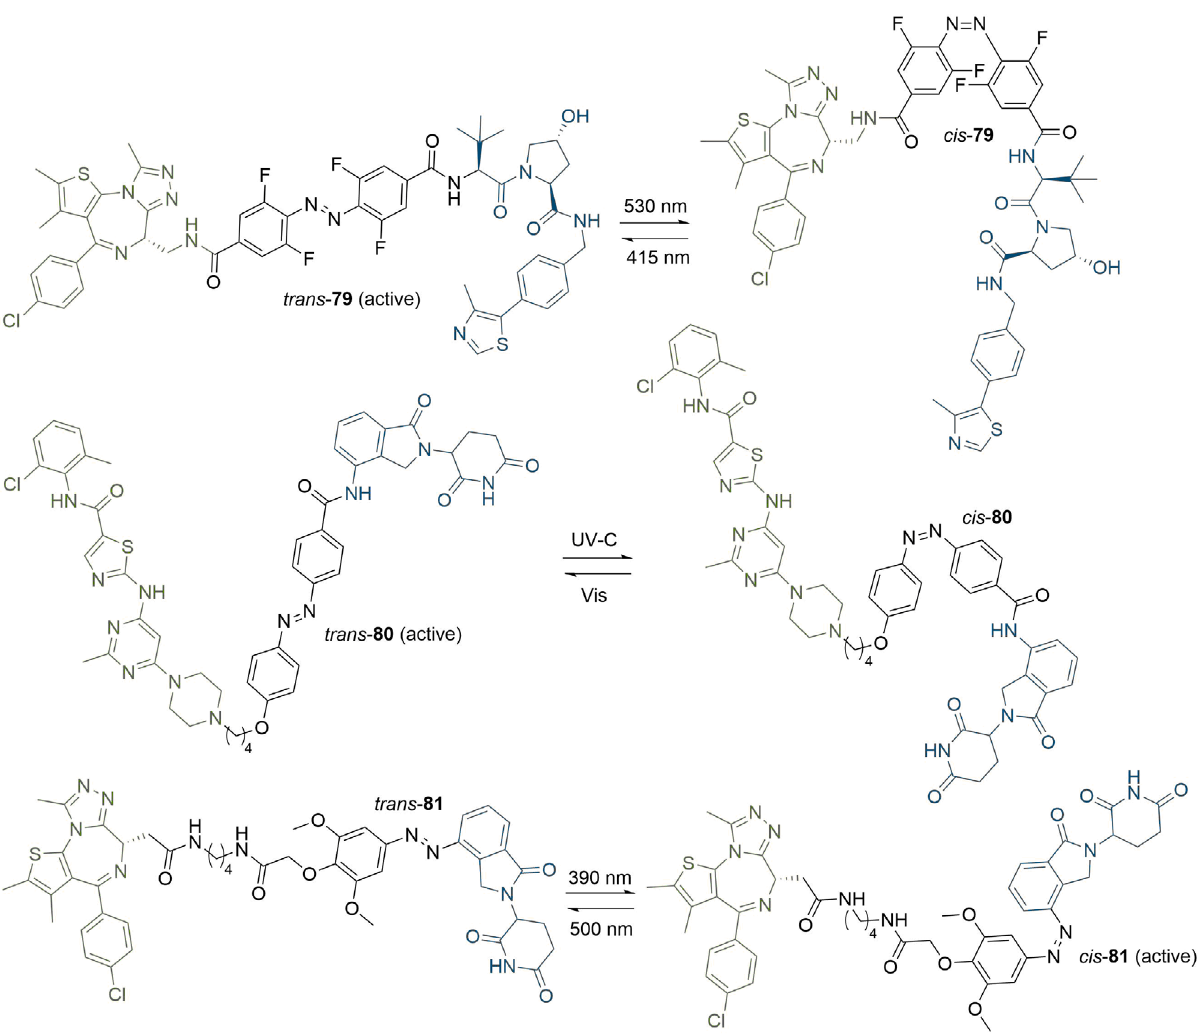
Figure 16. PROTACs with photoswitchable linkers. PROTACs 79 and 80 are active degraders in their trans configuration, whereas 81 is active in its cis configuration. The wavelengths required for conversion between the trans and cis forms are given above and below the Table 3. Key considerations for linker motifs described Structure